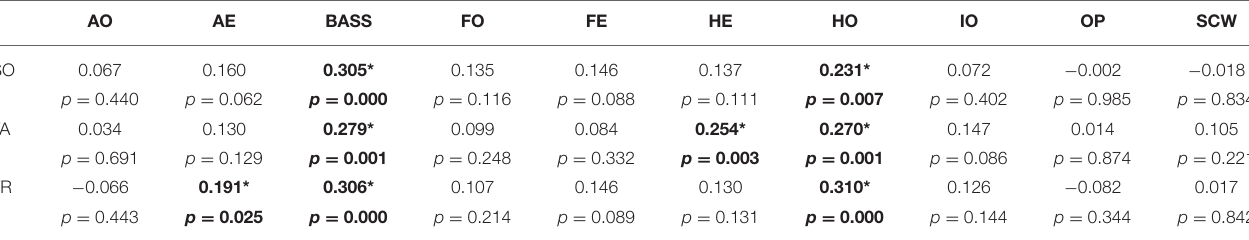
TABLE 4 | Results of the correlation analysis (Spearman’s rho) for women with DRAM within 25 months and more after delivery ( N =